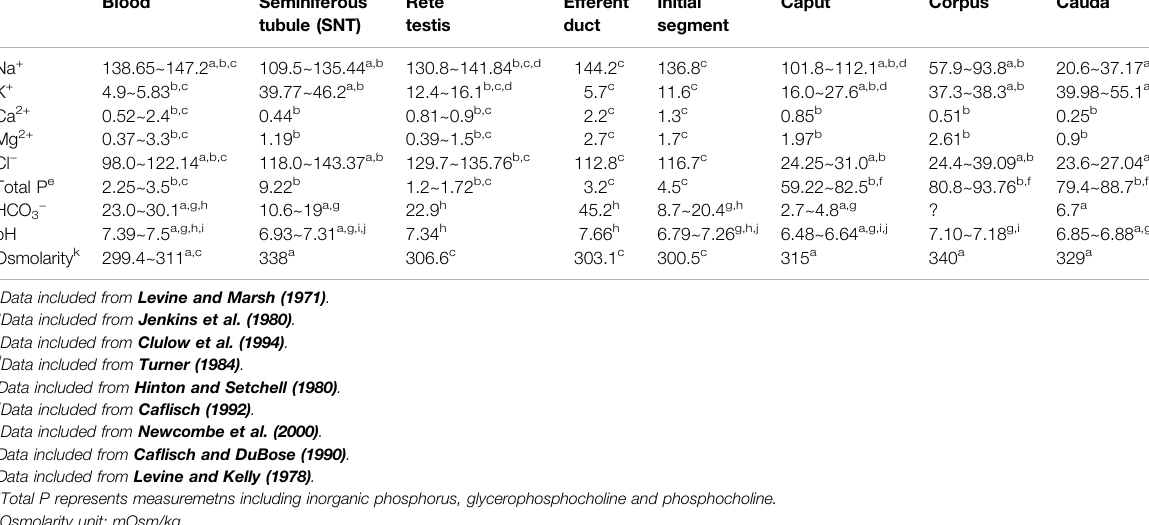
TABLE 1 | Concentrations of inorganic elements (mM) and pH in blood plasma and intraluminal fl uids from the excurrent duct of rats.